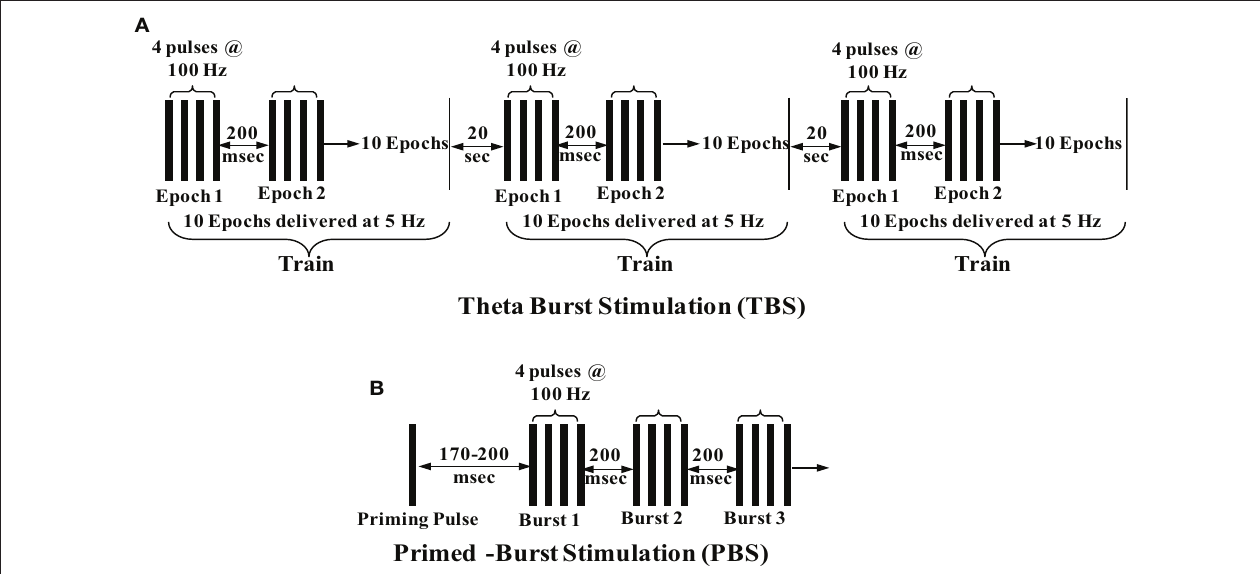
Figure 1 | Schematic depiction of standard theta burst stimulation and primed-burst stimulation. (A) TBS consists of three trains of stimuli delivered 20 s apart. Each train is composed of 10 stimulus epochs delivered at 5 Hz (200 ms apart) with each epoch consisting of four pulses at 100 Hz. (B) PBS consists of a single priming pulse followed 170–200 ms later by a burst of stimuli delivered at 100–200 Hz (200 ms